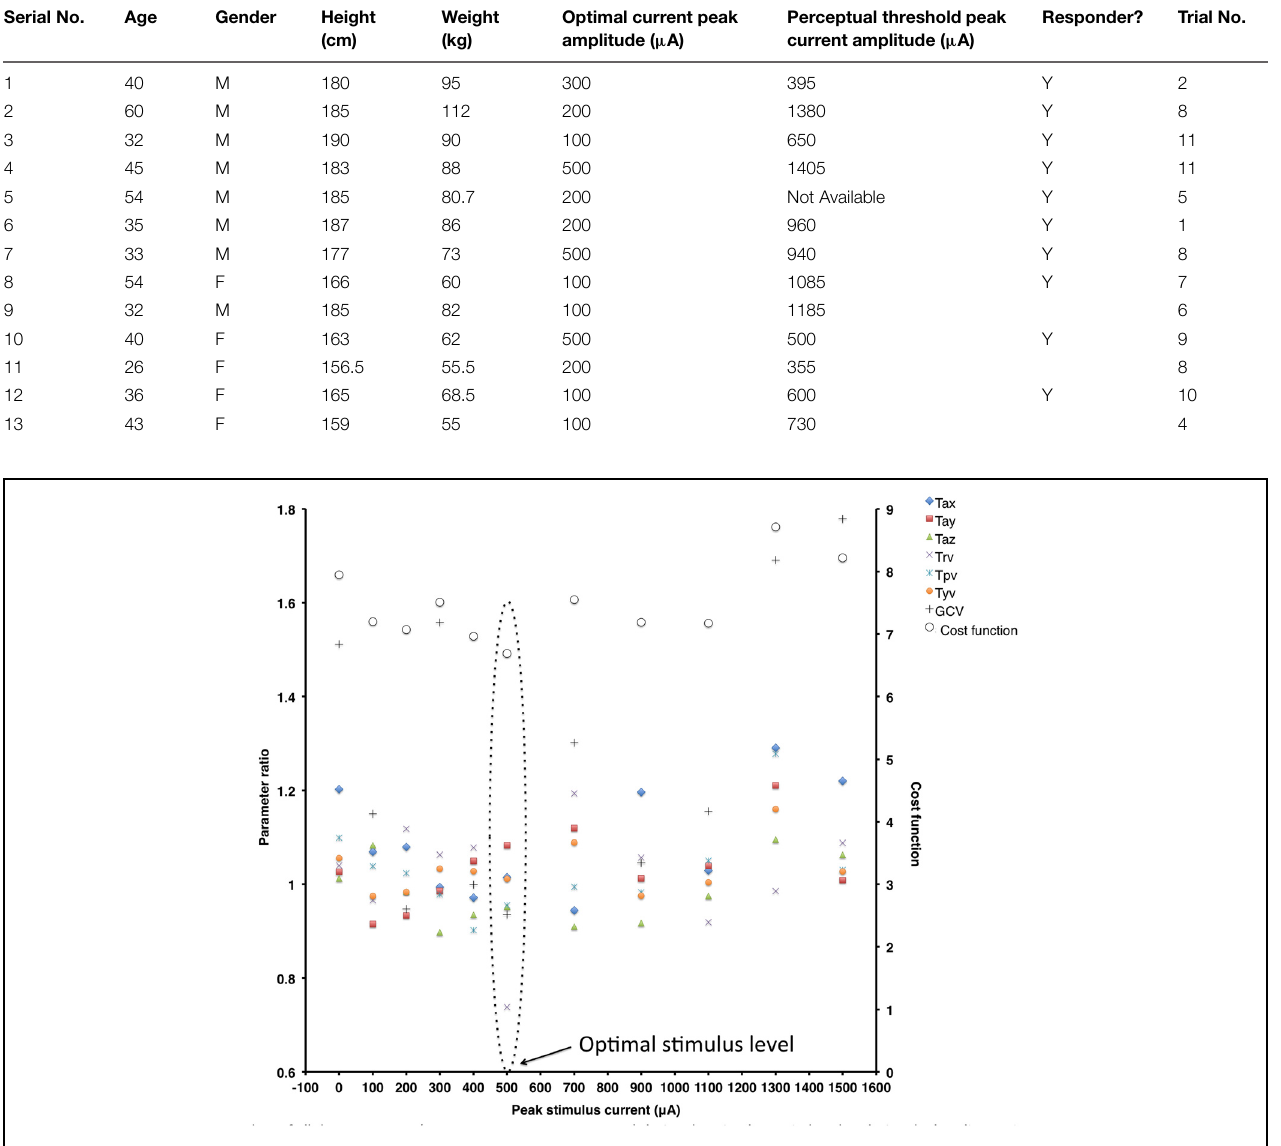
(plotted on the secondary y -axis on the right) at different peak stimulus amplitudes for a typical subject. Note that for this subject, locomotor balance performance improved at the peak stimulus amplitude of 500 μ